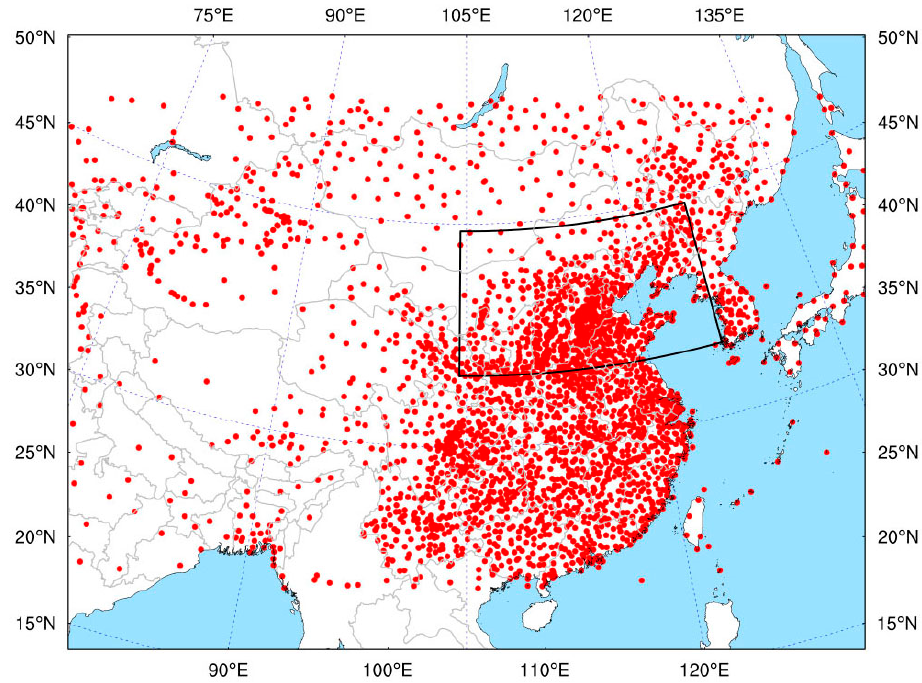
Figure 1. The domains of RMAPS. The outside box indicates Domain 1 and the inner black box indicates Domain 2. The red points represent the distribution of the ground sites.